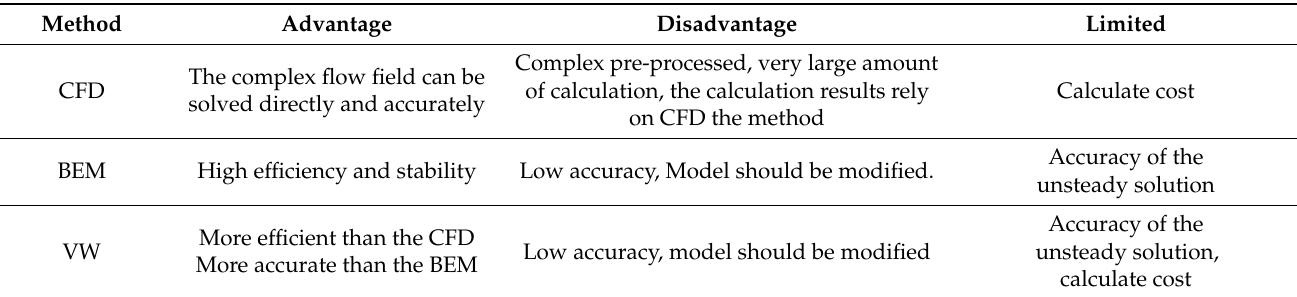
Table 1. The calculation methods of aerodynamic characteristics of wind turbine